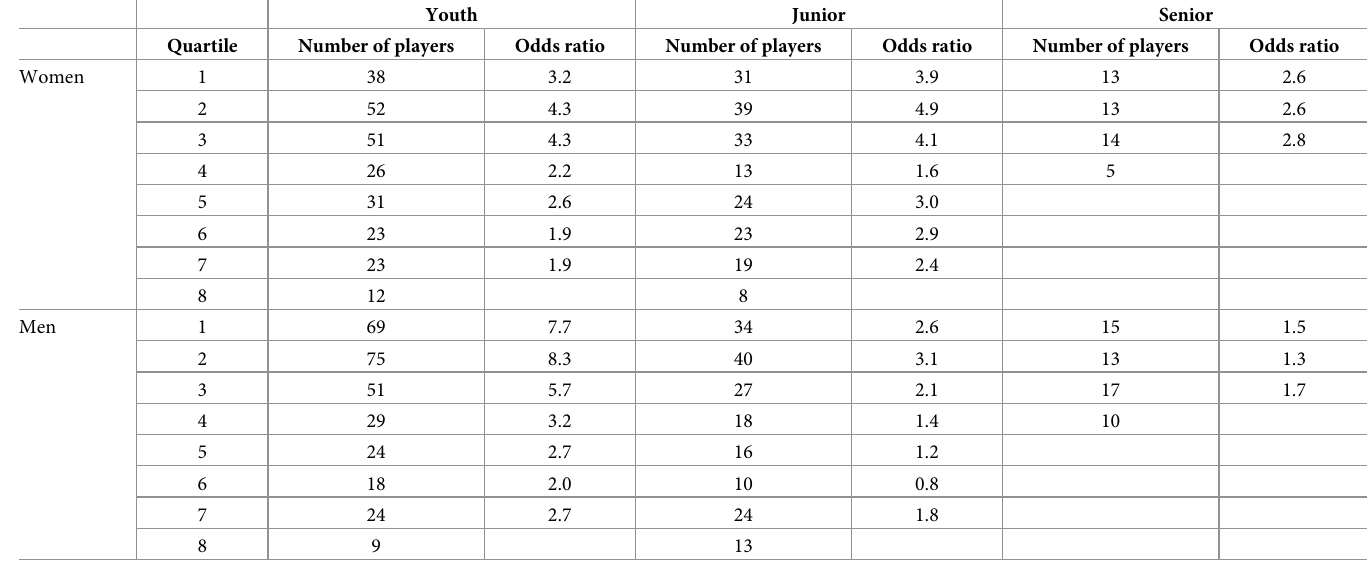
Table 2. Number of players selected to the different national team categories, with odds ratios. Youth Junior Senior Quartile Odds